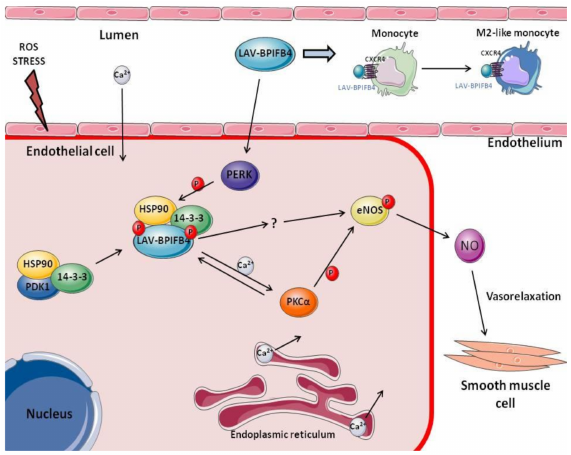
Figure 1. LAV-BPIFB4 mechanism of action. Schematic representation of LAV-BPIFB4 role in di ff erent pathways in endothelial cells and immune compartment. LAV-BPIFB4 is localized into EC